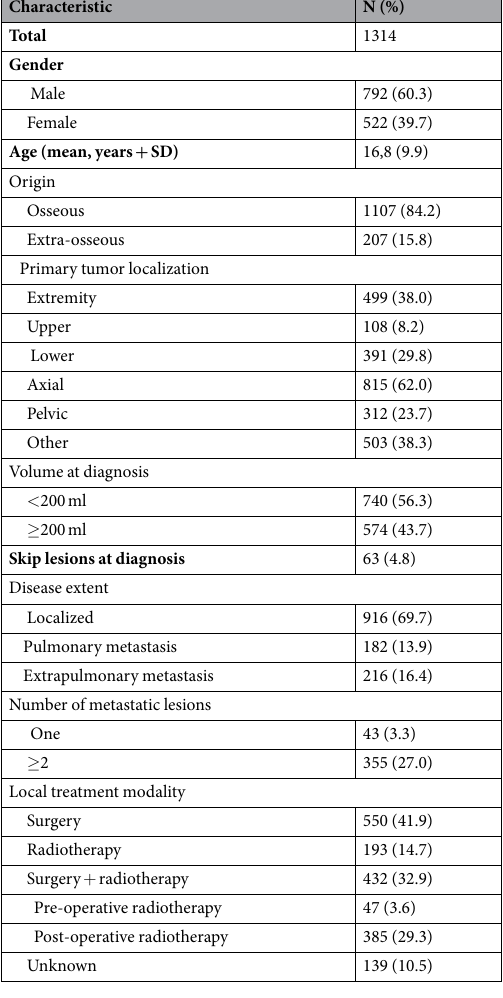
Table 1. Patient demographics at diagnosis. SD = standard deviation. Continuous variables are presented by means along with corresponding standard deviation between brackets, categorical variables as a number with the percentage between